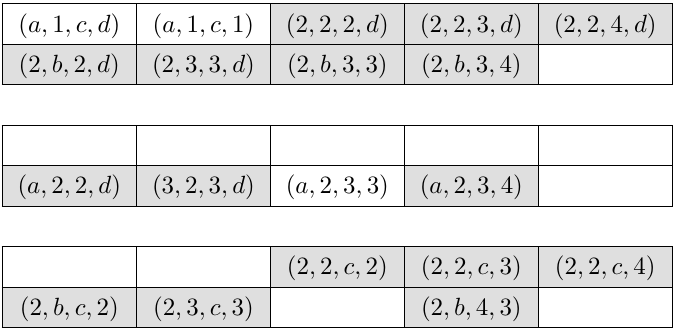
Table 7 . Infinite sequences of type IV singularities. The second and third tables are obtained from the first by the exchanges ( a, b ) and ( c, d ) respectively. The empty entries correspond to either a = 1 or c = 1 or invariance under exchange. Gray entries are reducible to previous types of singularities. This table is adapted from